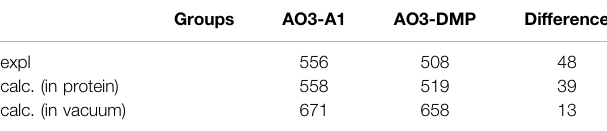
TABLE 3 | Contributions of the major residues to the absorption energies in AO3- A1 and AO3-DMP